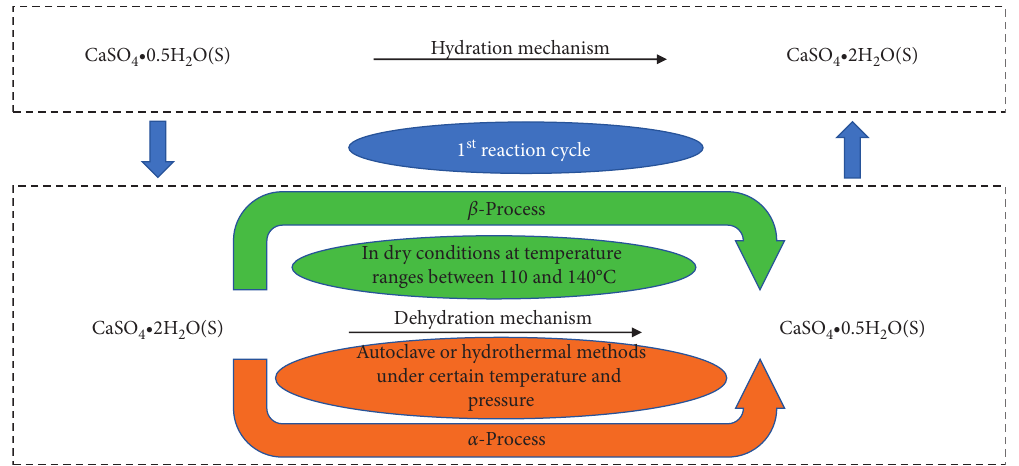
Figure 1: The mechanism of the 1st reaction cycle [17,